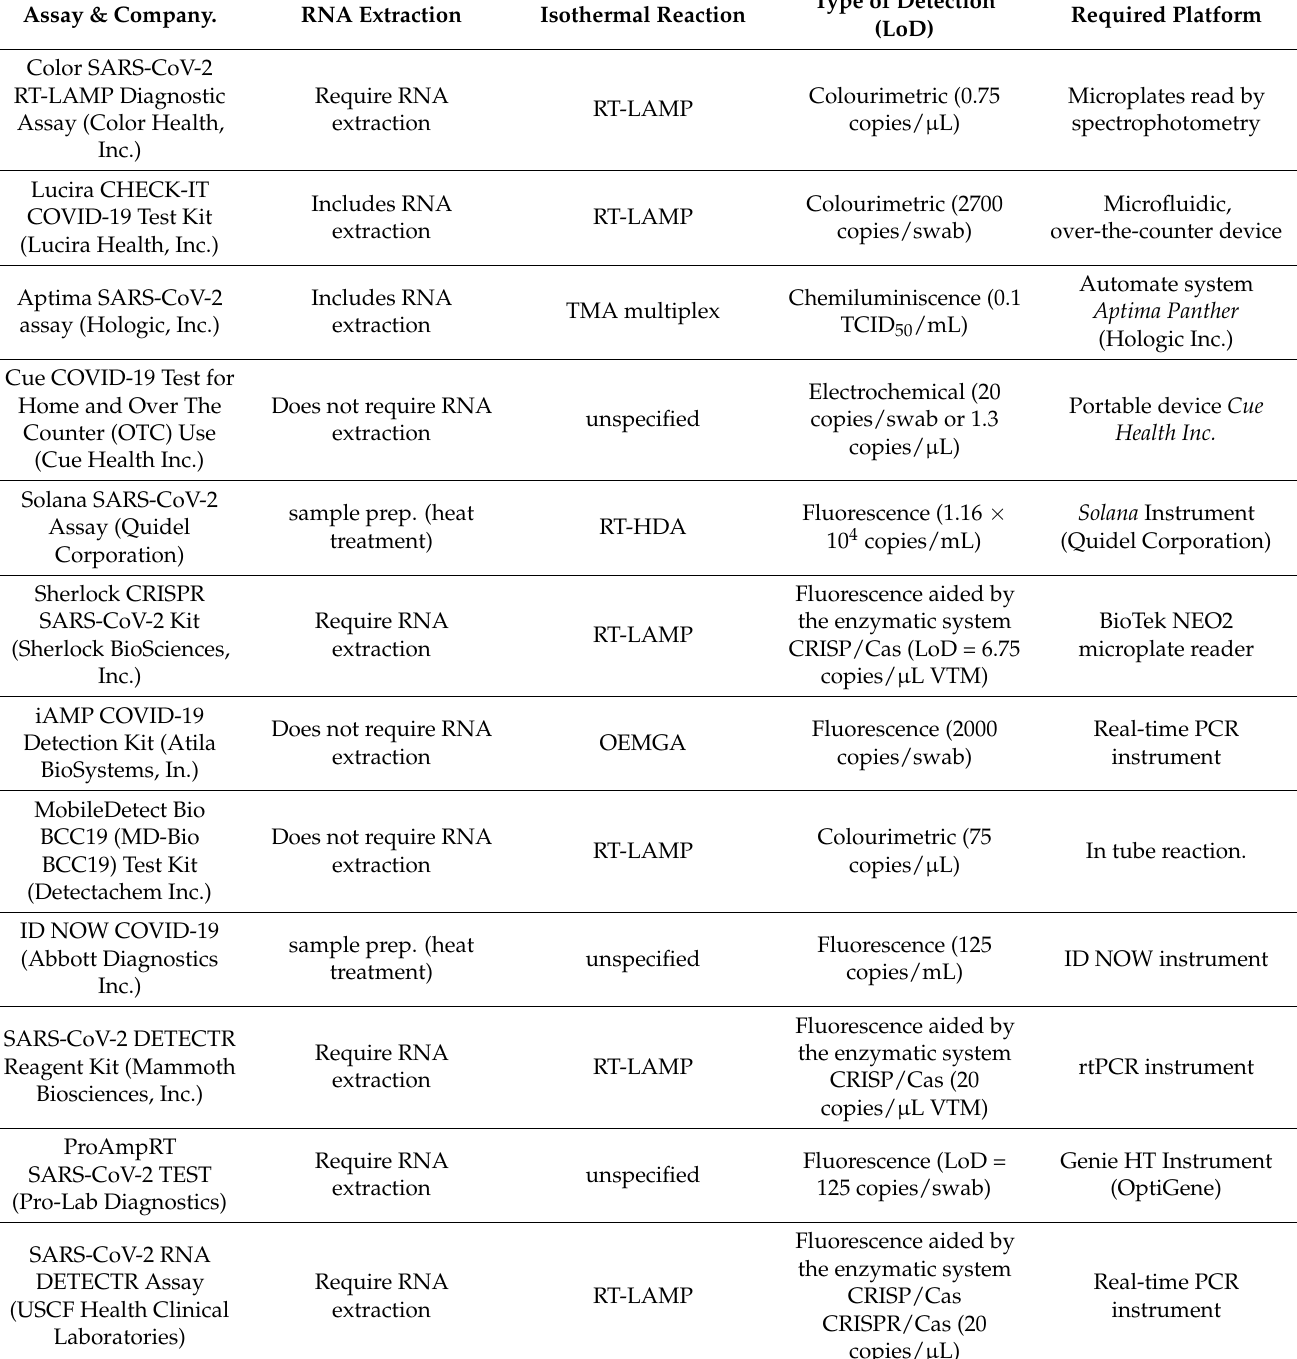
Table 1. Isothermal NAATs under Food and Drug Administration-Emergency Use Authorization (FDA-EUA, non- exhaustive). All data were collected from the documentation attached to each assay on the FDA website [41]. Assay &